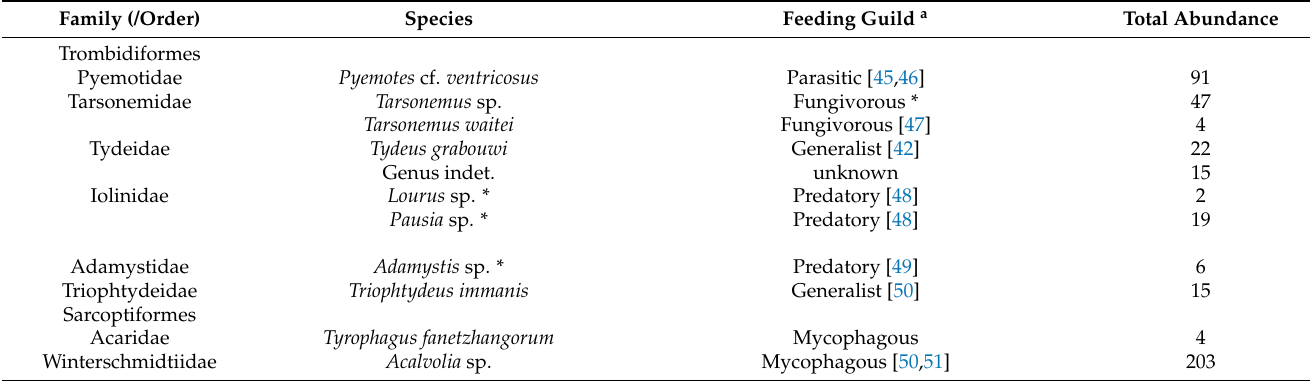
Table 1. Native mite species extracted from Dasineura dielsi galls collected from Acacia cyclops trees in the Western Cape of South Africa. These mite species were recovered from both rearing cages and the ethanol wash experiment. Feeding guild was assigned based on published literature where